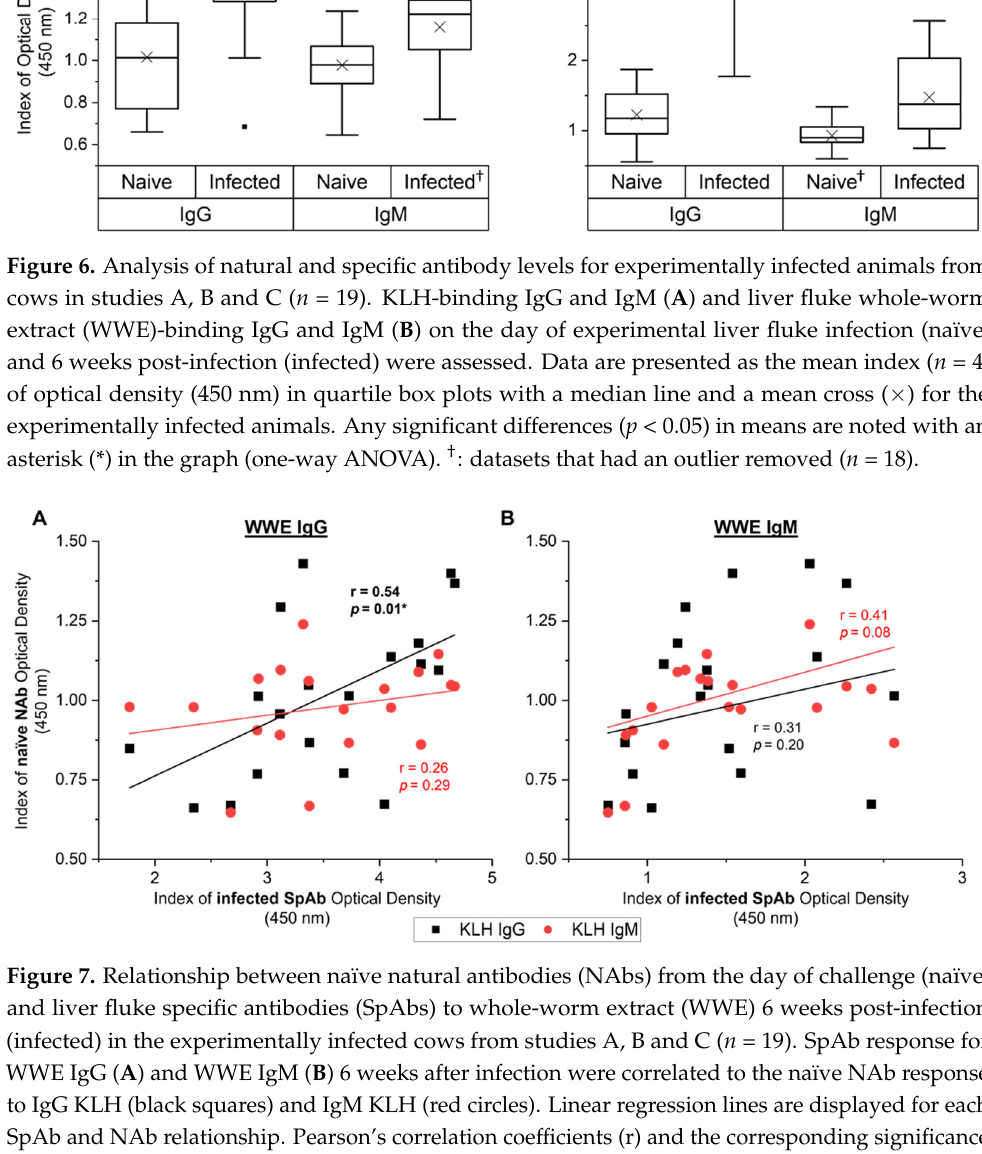
Figure 6. Analysis of natural and specific antibody levels for experimentally infected animals from cows in studies A, B and C ( n = 19). KLH-binding IgG and IgM ( A ) and liver fluke whole-worm extract (WWE)-binding IgG and IgM ( B ) on the day of experimental liver fluke infection (naïve) and 6 weeks post-infection (infected) were assessed. Data are presented as the mean index ( n = 4) of optical density (450 nm) in quartile box plots with a median line and a mean cross (×) for the exper- imentally infected animals. Any significant differences ( p < 0.05) in means are noted with an asterisk (*) in the graph (one-way ANOVA). † : datasets that had an outlier removed ( n = 18).